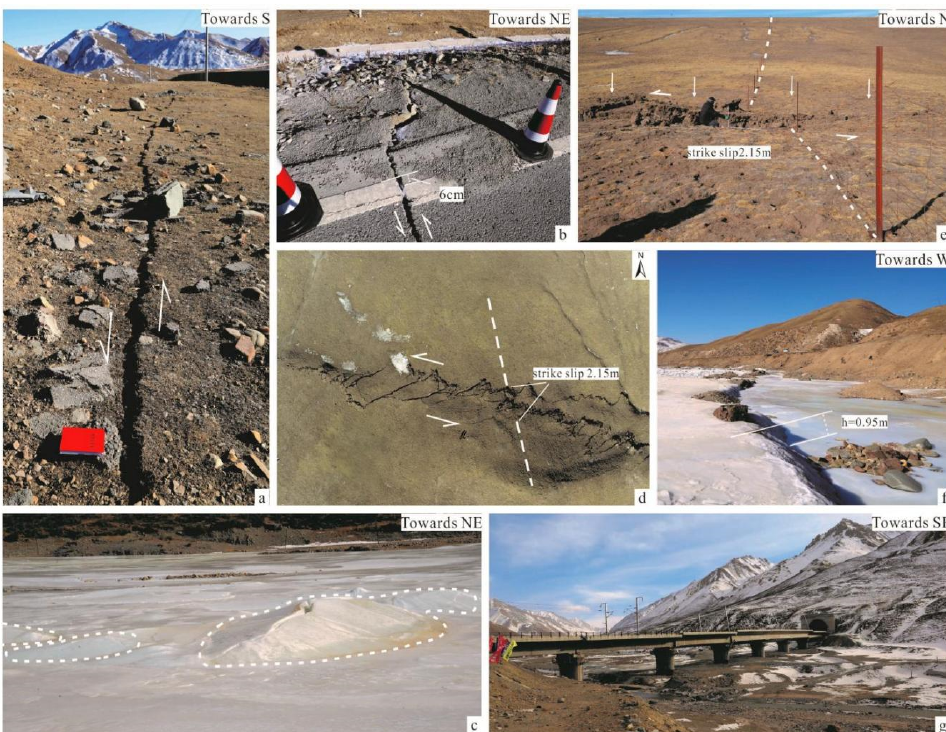
Figure 8. Field investigation results. ( a ) Ground fissure. ( b ) Highway left-slip dislocation. ( c ) Ice extrusion bulges. ( d ) Surface left-slip dislocation, associated with tension fissures. ( e ) Fence left-slip dislocation. ( f ) Scarps. ( g ) Railroad bridge overturned to the